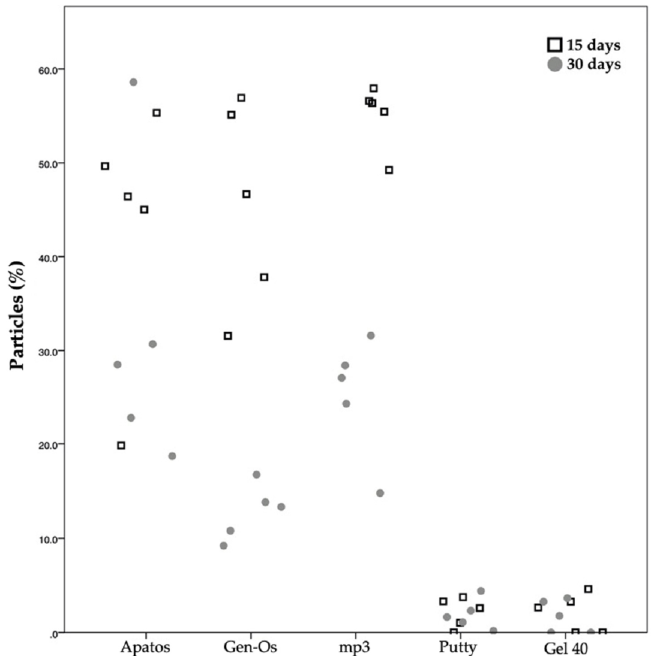
Figure 8. Scatter plot graph displaying the particles measurements for different materials and at the two assessment